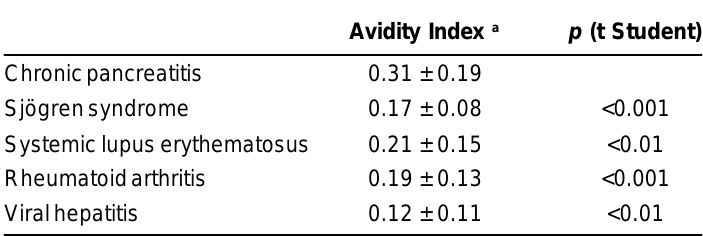
Coefficient of Avidity for Anti-CA-II